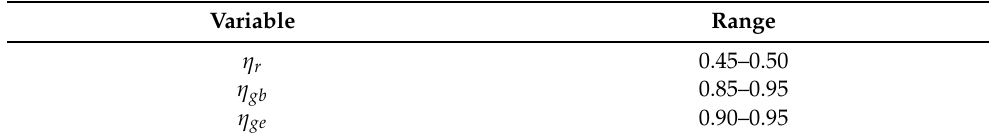
Table 1. Typical ranges of rotor, gearbox and generator efficiencies.